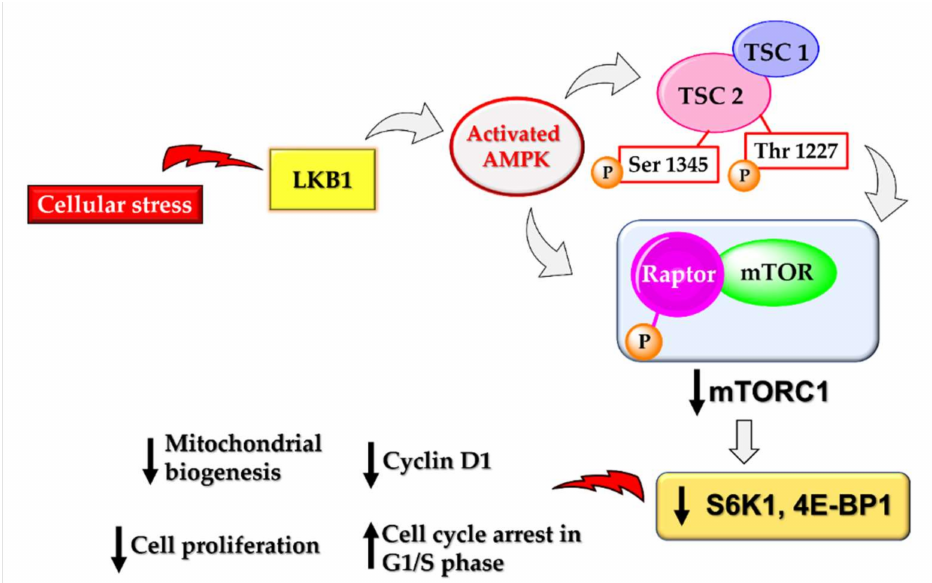
Figure 4. Activated AMPK-mediated downregulation of the mTORC1 complex can follow two pathways: through the phosphorylation and activation of tuberous sclerosis complex 2 (TSC 2) or via direct phosphorylation of raptor at S722 and S792. The deactivation of mTOR is subsequently followed by the inhibition of S6K1 and 4E-BP1, both of which are responsible for the initiation of protein translation and maintenance of cell size and